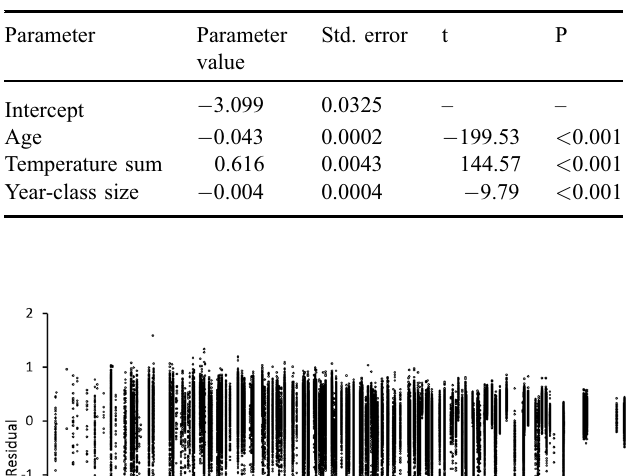
Table 2. The parameter values and test statistics for the effects of age (age in years 1 – 10), temperature sum (calculated based on daily mean water temperature ( ° C) from 1st of June to end of September in each year) and year-class size (number of pikeperch) on length increments of pikeperch. Temperature sums, year-class sizes and length increments were log-transformed.